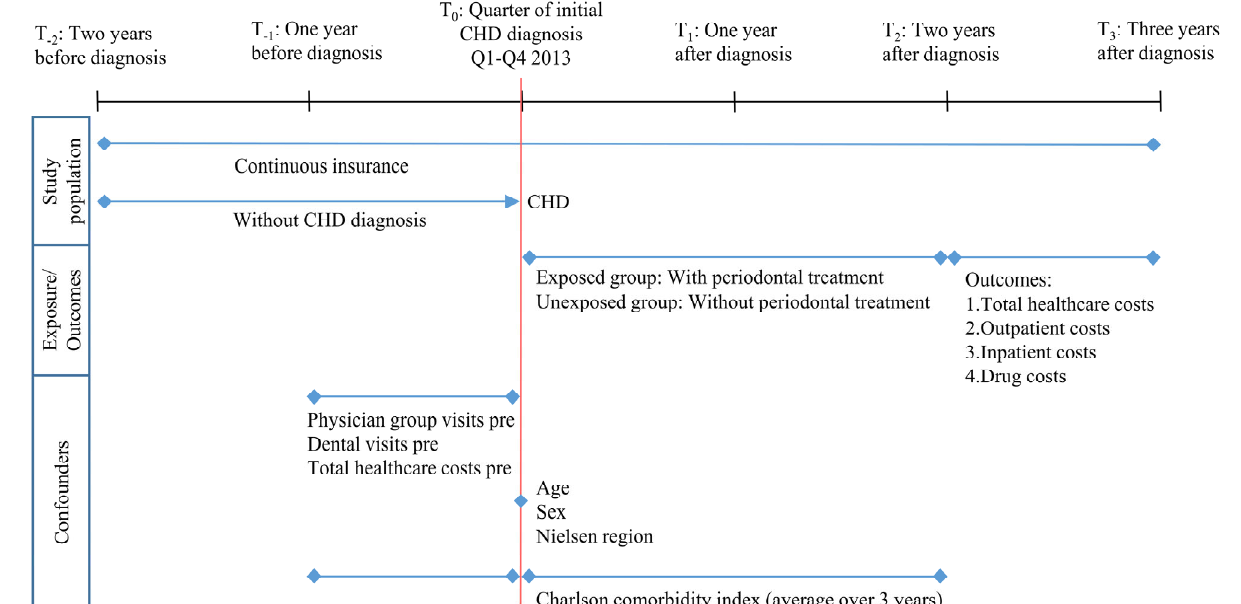
Figure 1. Study timeline and variables definition. Q1: first quarter of the year. Q4: fourth quarter of the year. Pre: one year before index quarter.